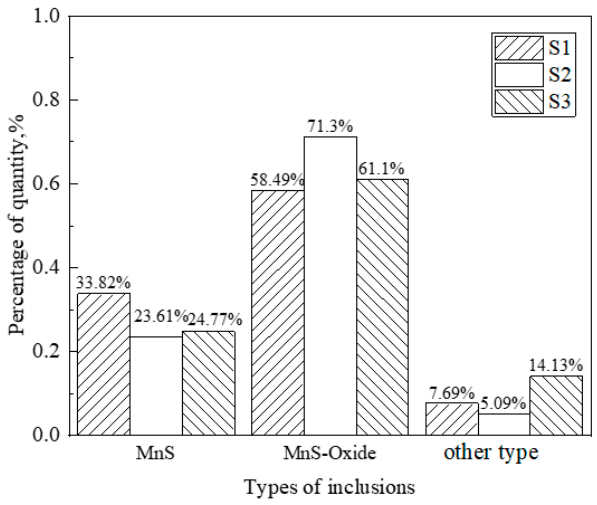
Figure 3. Types and percentage of inclusions in samples.